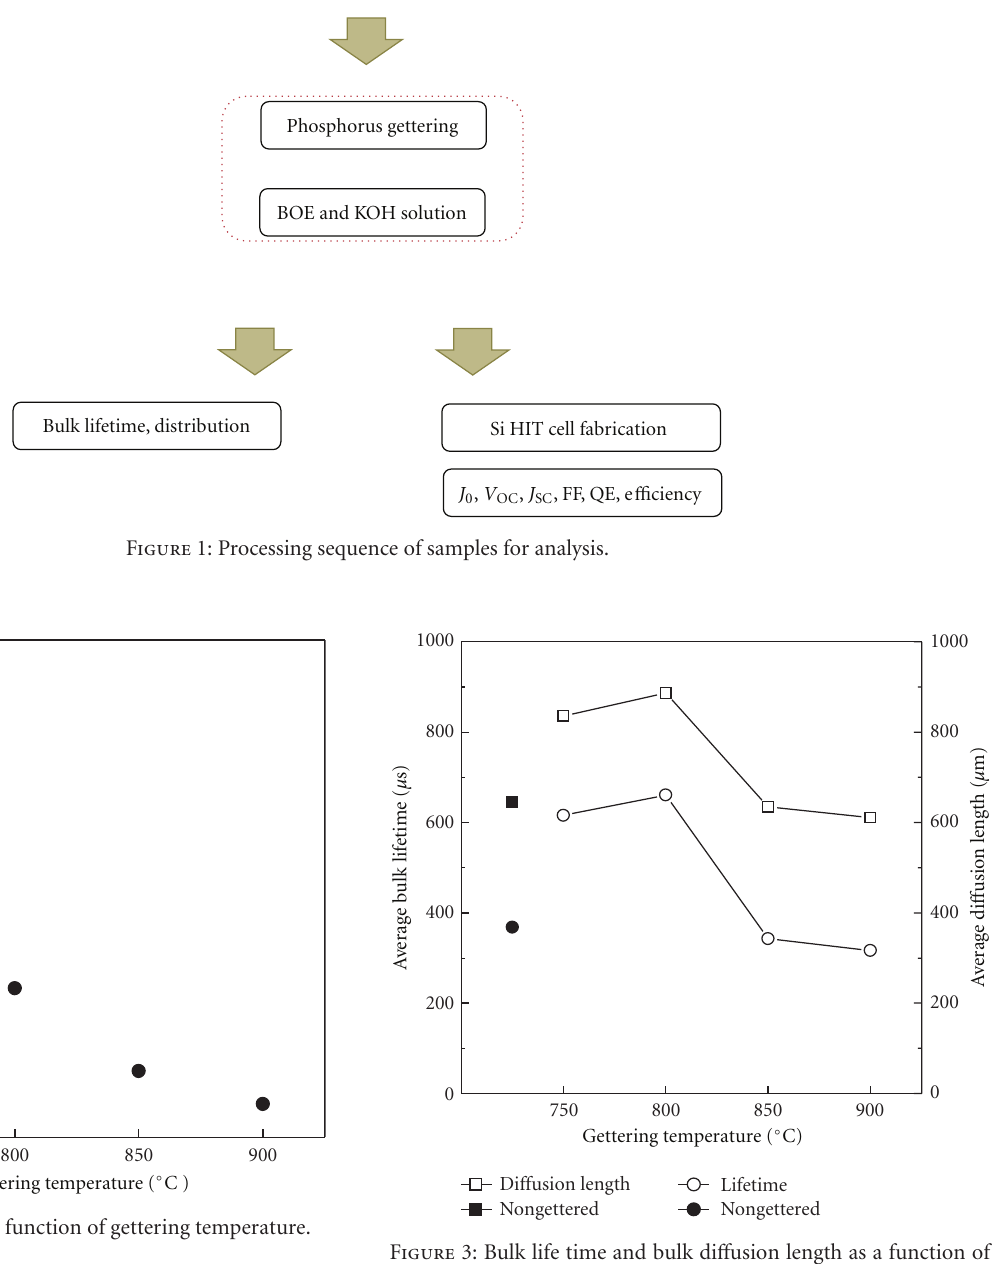
Figure 3: Bulk life time and bulk di ff usion length as a function of gettering